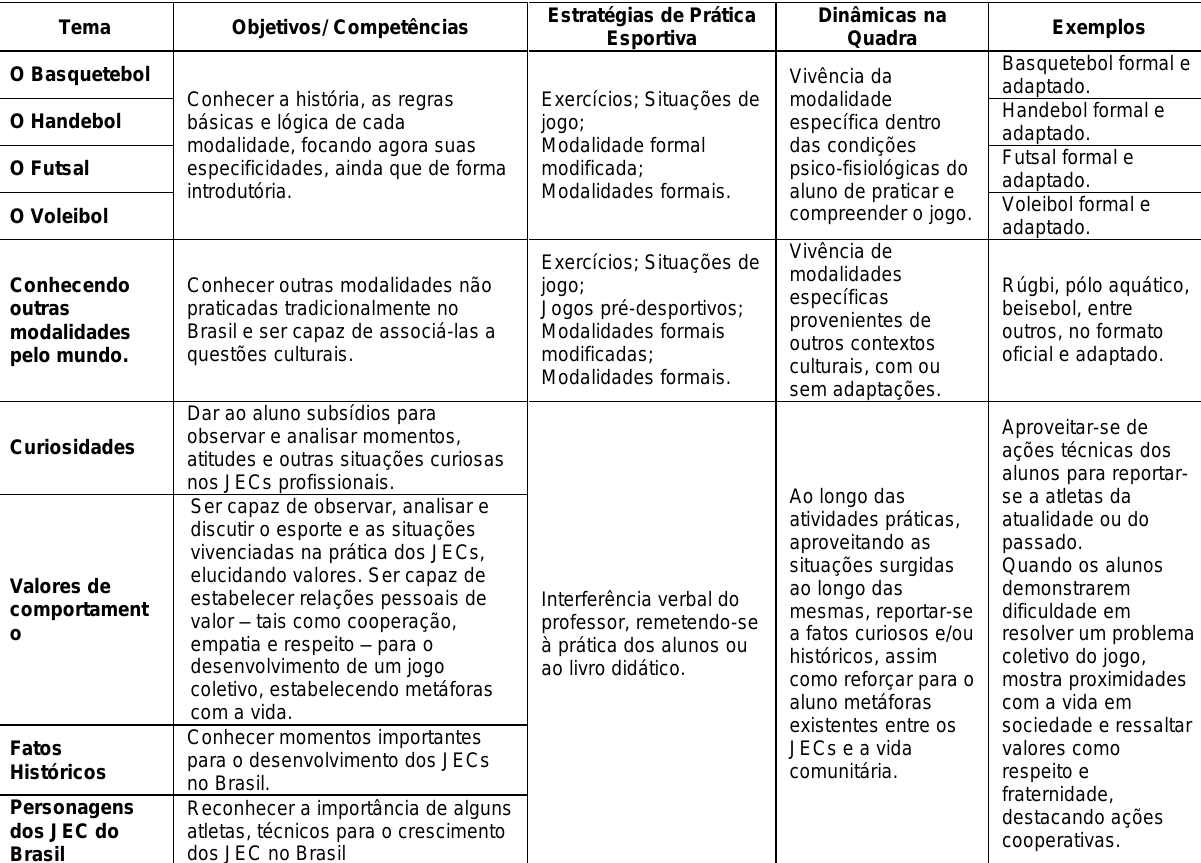
Tabela 2. Possíveis temas específicos para a prática dos JECs: objetivos, competências, estratégias e dinâmicas (adaptado de GALATTI, 2006,